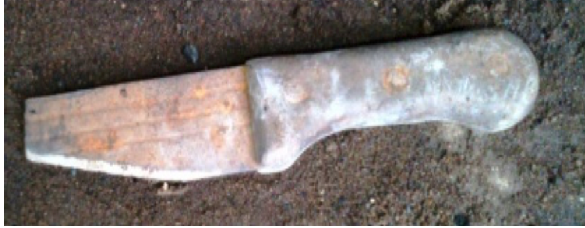
Figure 5 | A cutlass improvised as chisel for cutting. Photograph by Kingsley O. Emeriewen, 2012.